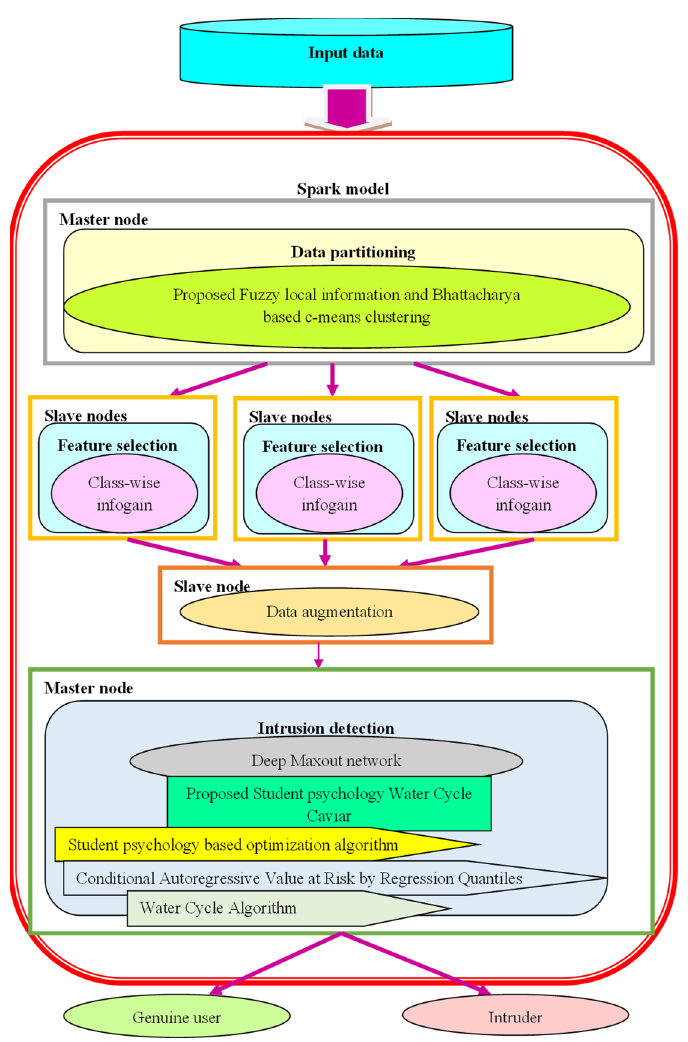
Figure 1. The architecture of intrusion detection using the proposed SPWCC-based DMN with spark model.